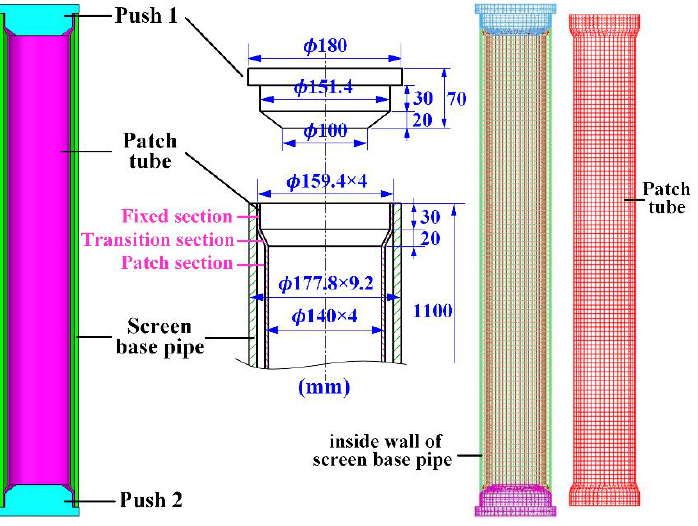
Figure 8. Model building and meshing.